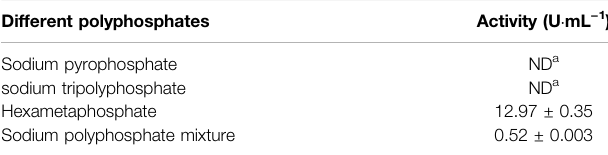
TABLE 5 | Effect of polyphosphate with different degrees of polymerization on the enzyme activity of D fi PPK2-III. Different polyphosphates